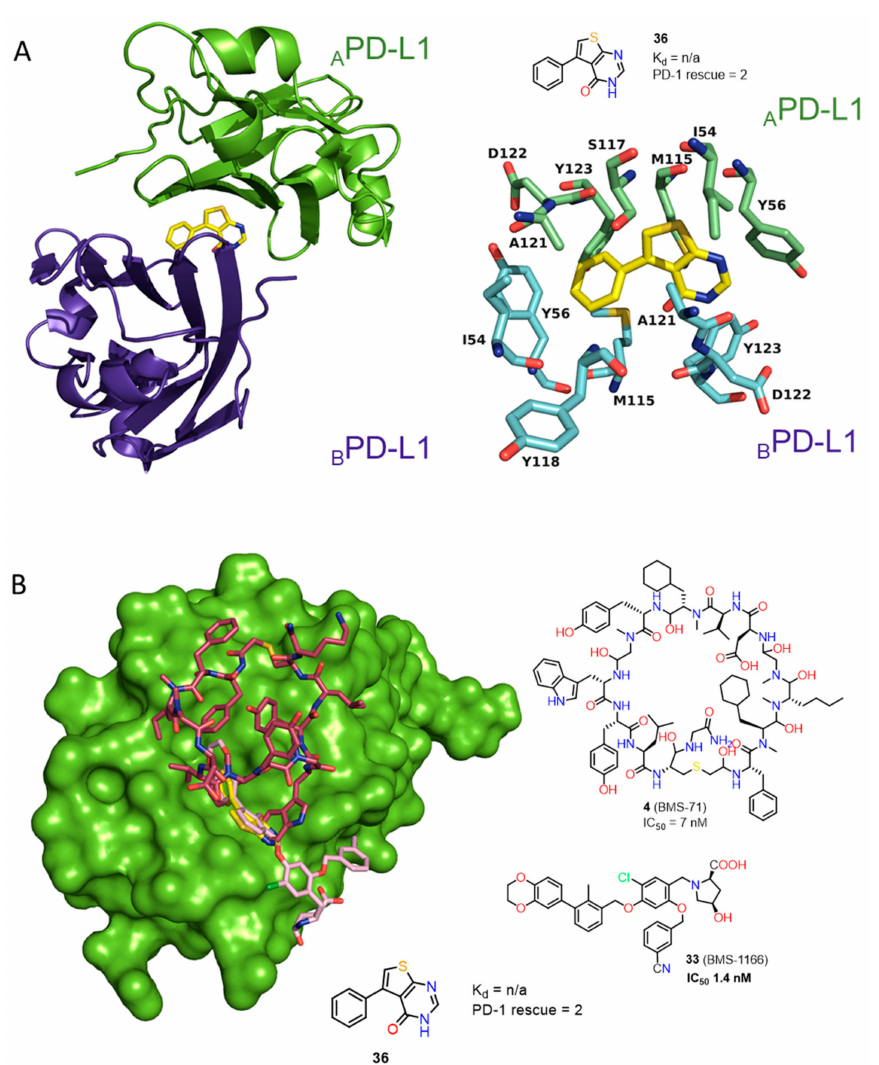
Figure 17. ( A ) Fragment 36 bound to dimeric PD-L1. Detailed interactions of 36 (yellow) at the binding cleft of PD-L1. 36 binds at a hydrophobic tunnel formed upon the PD-L1 dimerization. PDB: 6NM7 ( B ) Overlay of fragment 36 (yellow), BMS small molecule inhibitor 33 (light pink) and BMS macrocyclic inhibitor 4 (plum) (PDB codes: Fragment 1: 6NM7, BMS small molecule 5NIU: 6NM8, BMS peptide-71: